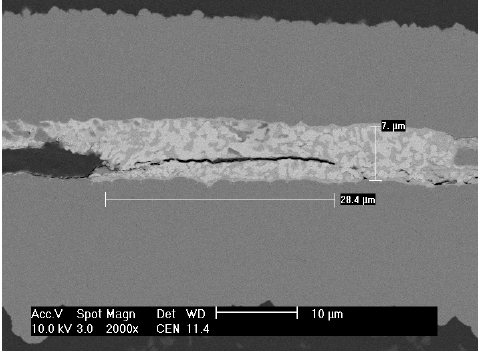
Figure 4. SnBi58 solder joint cracks after a thermo-compression bonding.